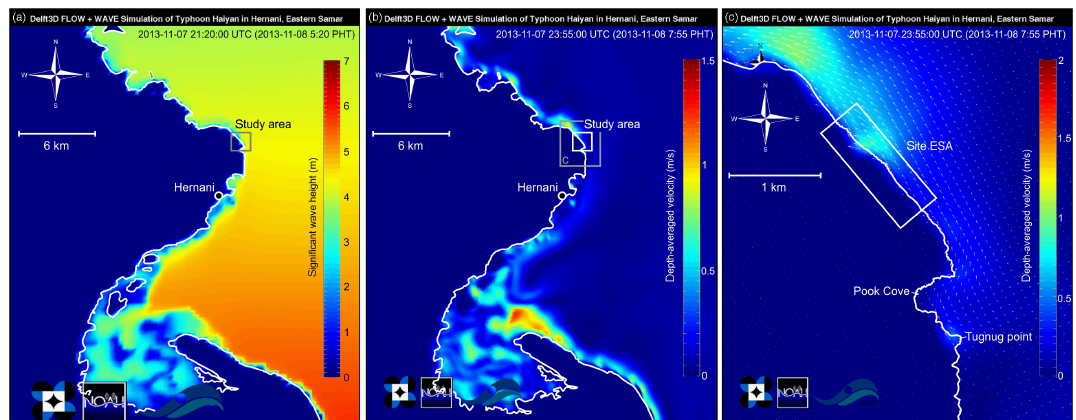
Figure 8. Results from the (phase-averaged) wave and storm surge model using Delft3D and Delft Dashboard software. (a) Maximum significant wave heights in Eastern Samar. Based on our model, maximum significant waves heights reached ca. 4–5m at ∼ 05:20PHT in the study area. However, wave heights seem to be underestimated when compared to previously published low-resolution models (Bricker et al., 2014; Fig. 3). (b, c) Even in the coupled hydrodynamic and wave model, combining pressure- and wind-driven surge as well as wave setup, the maximum depth-averaged flow velocities calculated for Eastern Samar (b) and the study area (c) remain below 1.5ms − 1 . Highest velocities at ESA are approached at ∼ 08:00PHT. PHT – Philippine Time; UTC – Coordinated Universal